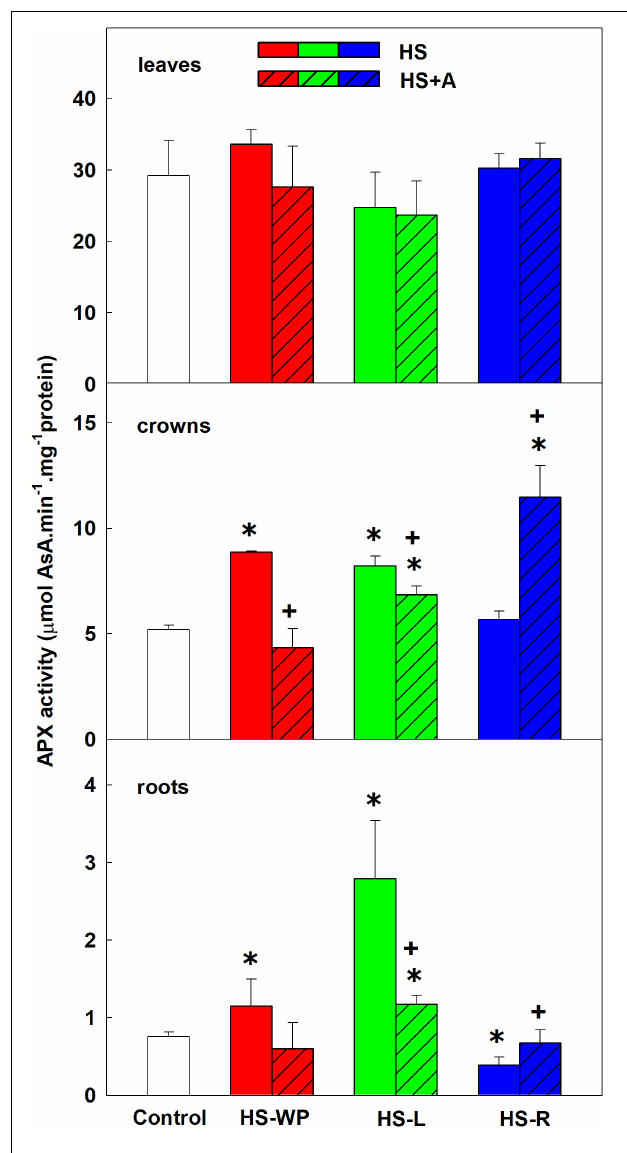
FIGURE 12 | The activity of ascorbate peroxidase (APX) in leaves, crowns and roots of rice seedlings exposed to heat stress directly (HS) or after acclimation (HS + A). Heat stress was applied to whole plants (HS-WP), to leaves (HS-L), or to roots (HS-R). Data are means ± SD. One-way ANOVA with Tukey’s post hoc test ( p < 0.05, n = 3) was used to compare controls to the HS treatments. Significant differences compared to control plants are indicated by asterisks ( ∗ ) while crosses (+) indicate significant differences between HS and HS + A